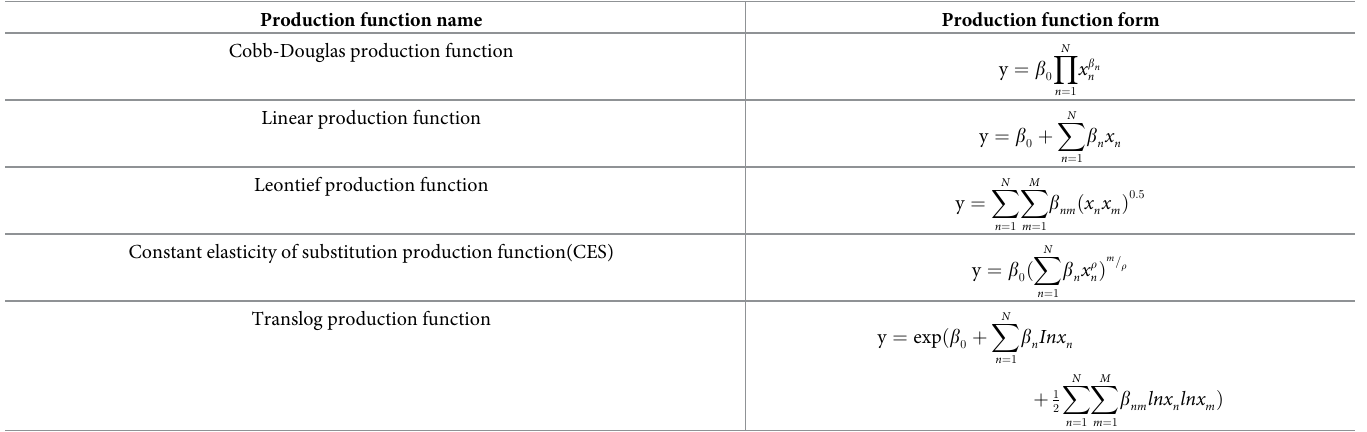
Table 3. Commonly used form of the production function.